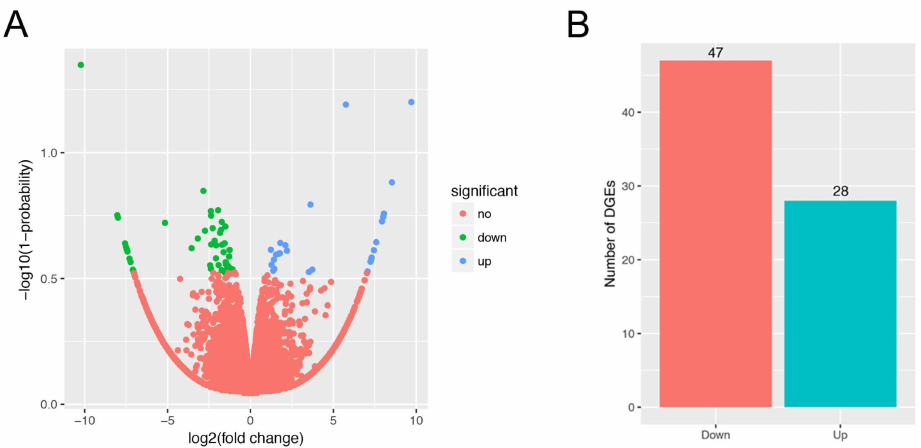
Figure 1. Identification of differentially expressed genes (DEGs). ( A ) Volcano plot showing DEGs in higher (H) and lower (L) groups. The x axis represents the value of log2 (L/H), and the y axis represents the value of − log10 (1-probability). Red, green, and blue dots represent unchanged, downregulated, and upregulated DEGs between the H and L groups; ( B ) Statistics of DEGs between the H and L groups. The x axis represents downregulated and upregulated genes, and the y axis represents the number of